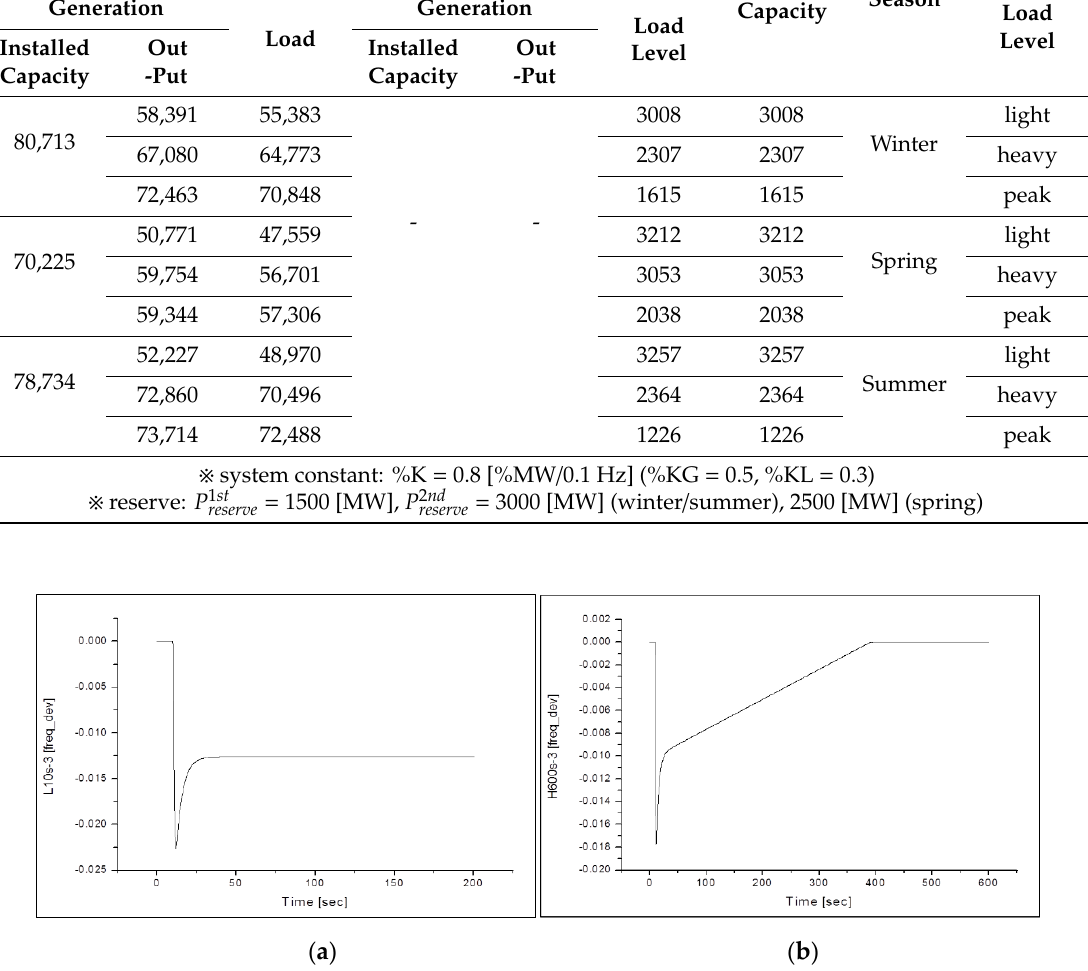
Table 9. Simulation data of the whole company.